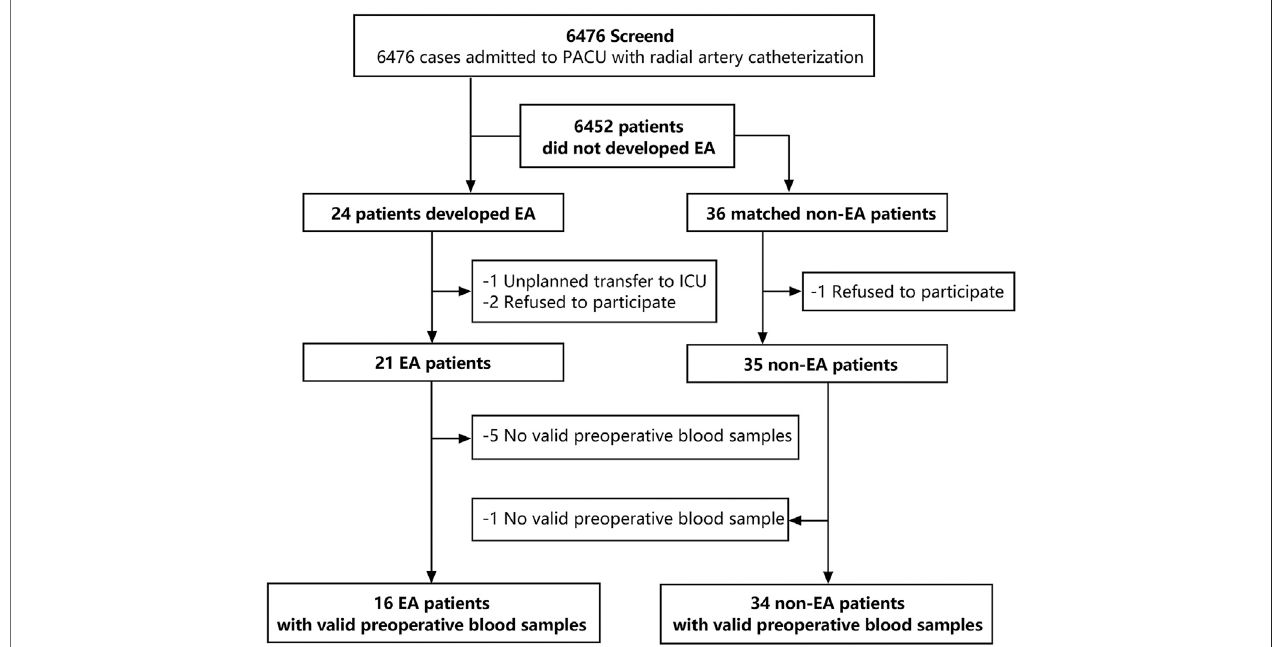
FIGURE 1 | Flow chart of the research design. 6,476 patients were screened for emergency agitation, and 24 patients developed EA. 36 non-EA patients were matched with a ratio of 1:1.5 according to gender, age, BSA, and surgery types. Finally, 16 valid preoperative blood samples in the EA group and 34 valid preoperative blood samples in the non-EA group were collected for further analyses.